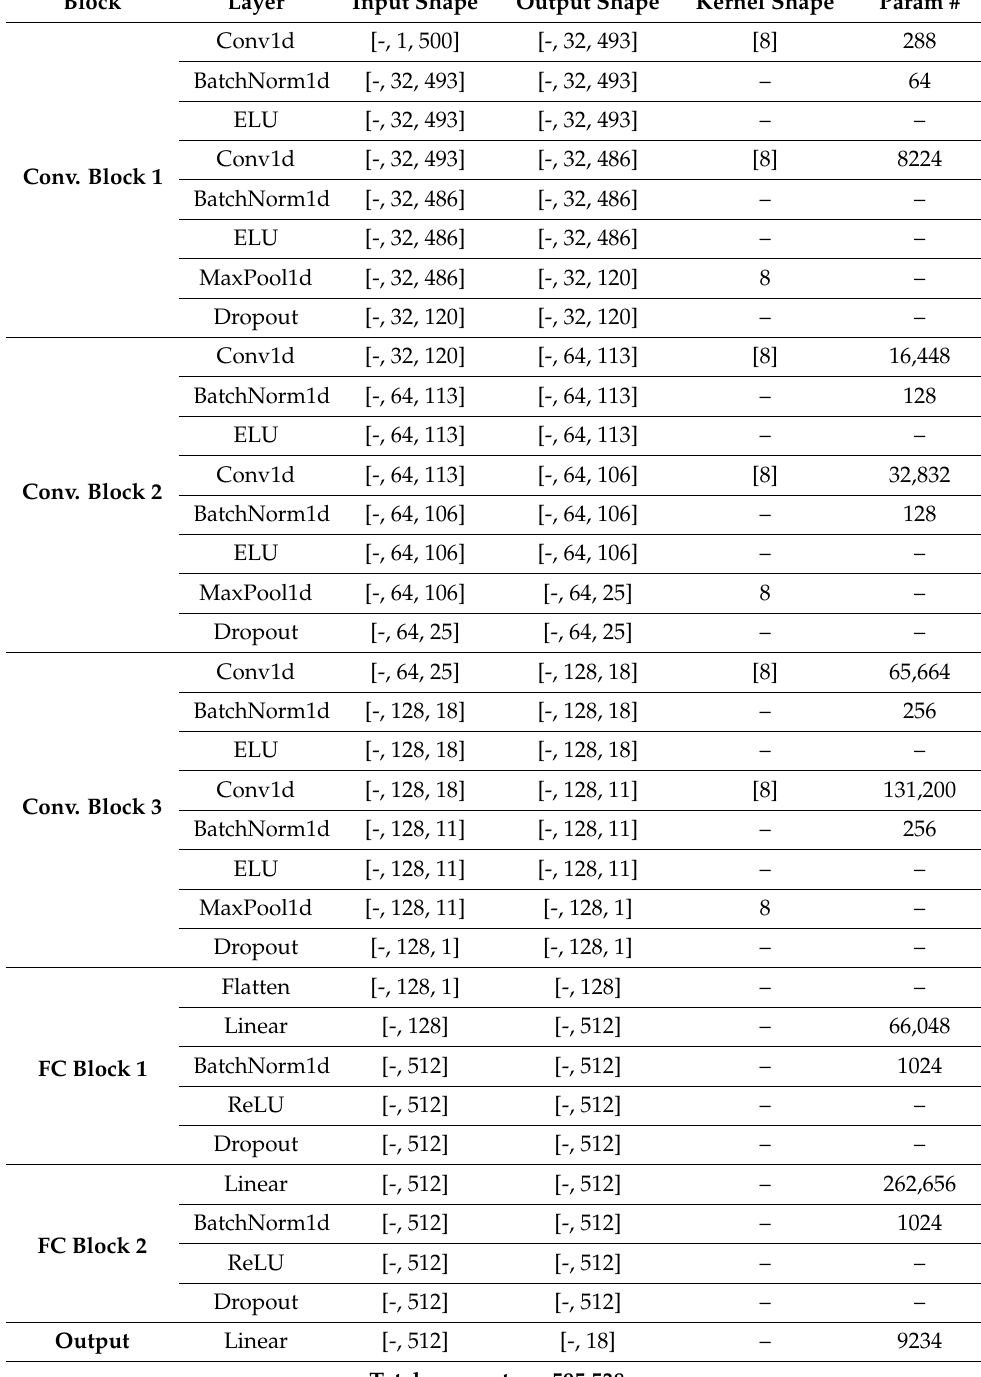
Table 3. Input/output/kernel shapes, and number of parameters for each layer of the